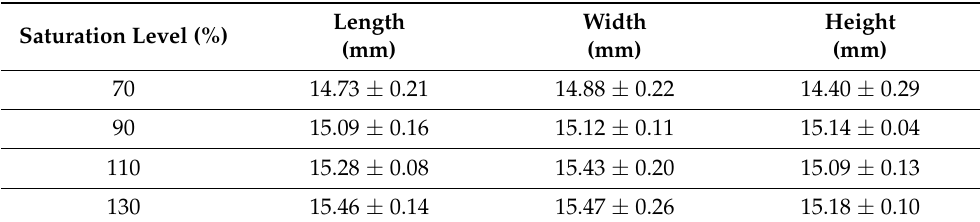
Table 1. Actual sizes for as-printed green cuboids of dimension 15 mm × 15mm × 15 mm printed with variations in